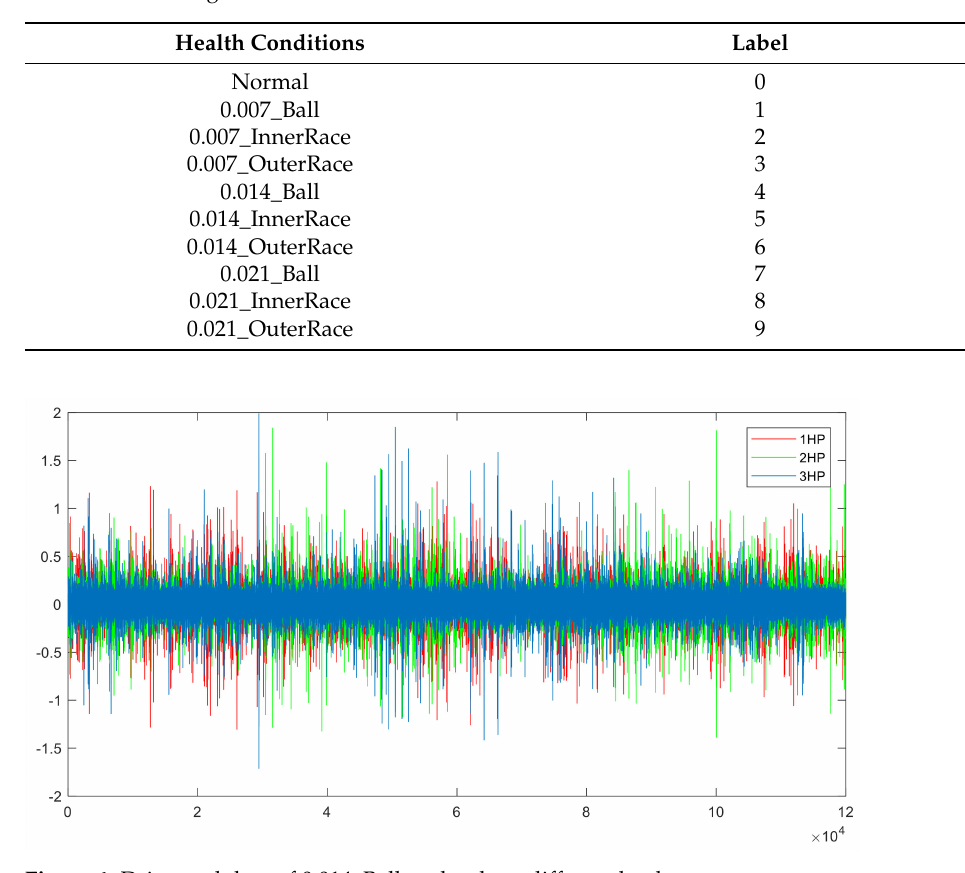
Figure 4. Drive-end data of 0.014_Ball under three different